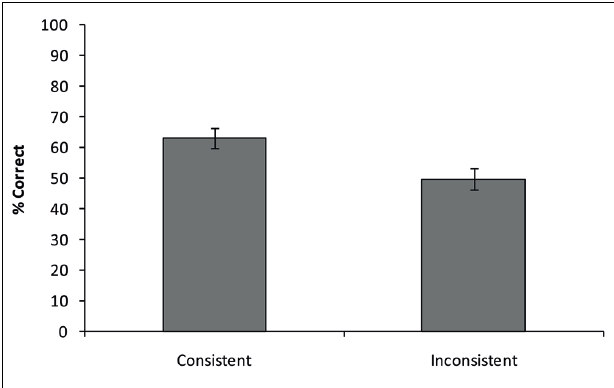
FIGURE 5 | Consistency effect obtained in Experiment 2. Similar to Experiment 1, participants were more accurate in discriminating objects presented on a consistent background, compared to an inconsistent background. Error bars reflect the standard error of the mean.